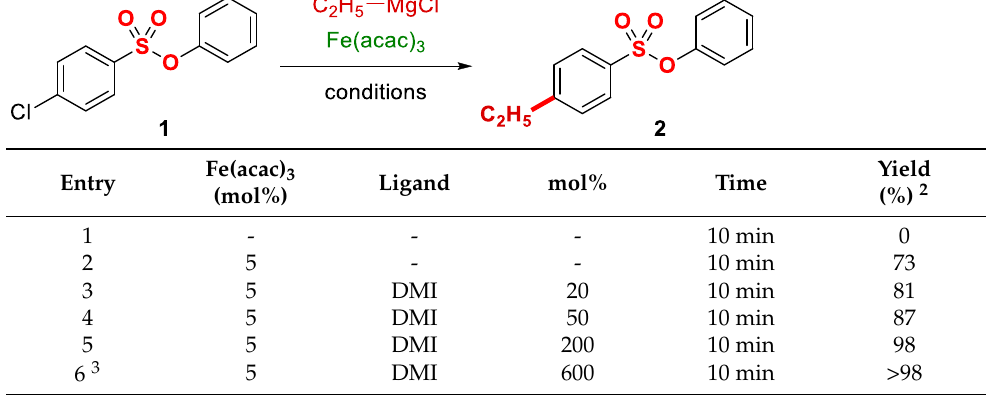
Figure 2. Iron-catalyzed C(sp 2 ) – C(sp 3 ) cross-coupling of aryl chlorobenzenesulfonates with alkyl Grignard reagents (this study).